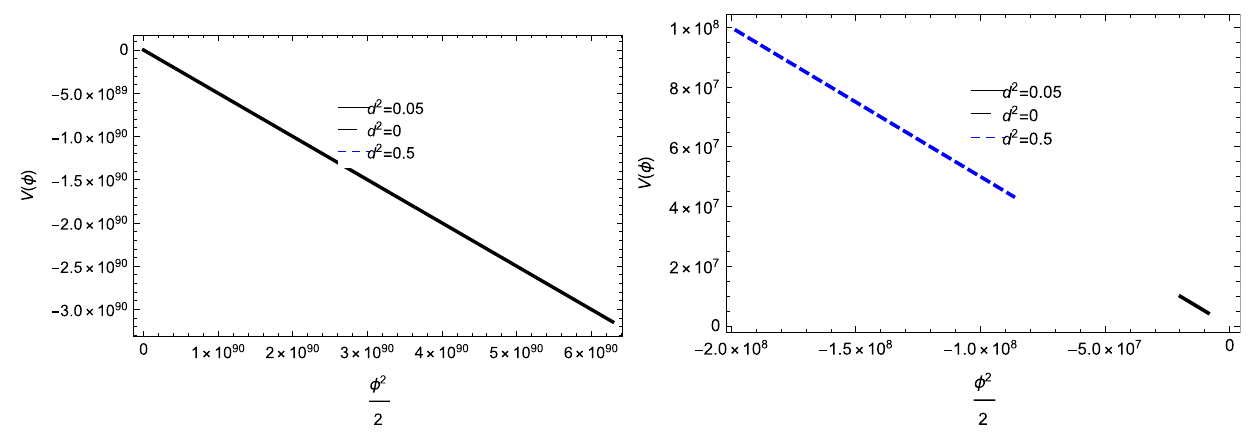
Fig. 21 Plot of φ verses V for u = 1 and u = 2 . 002 for quintessence scalar field